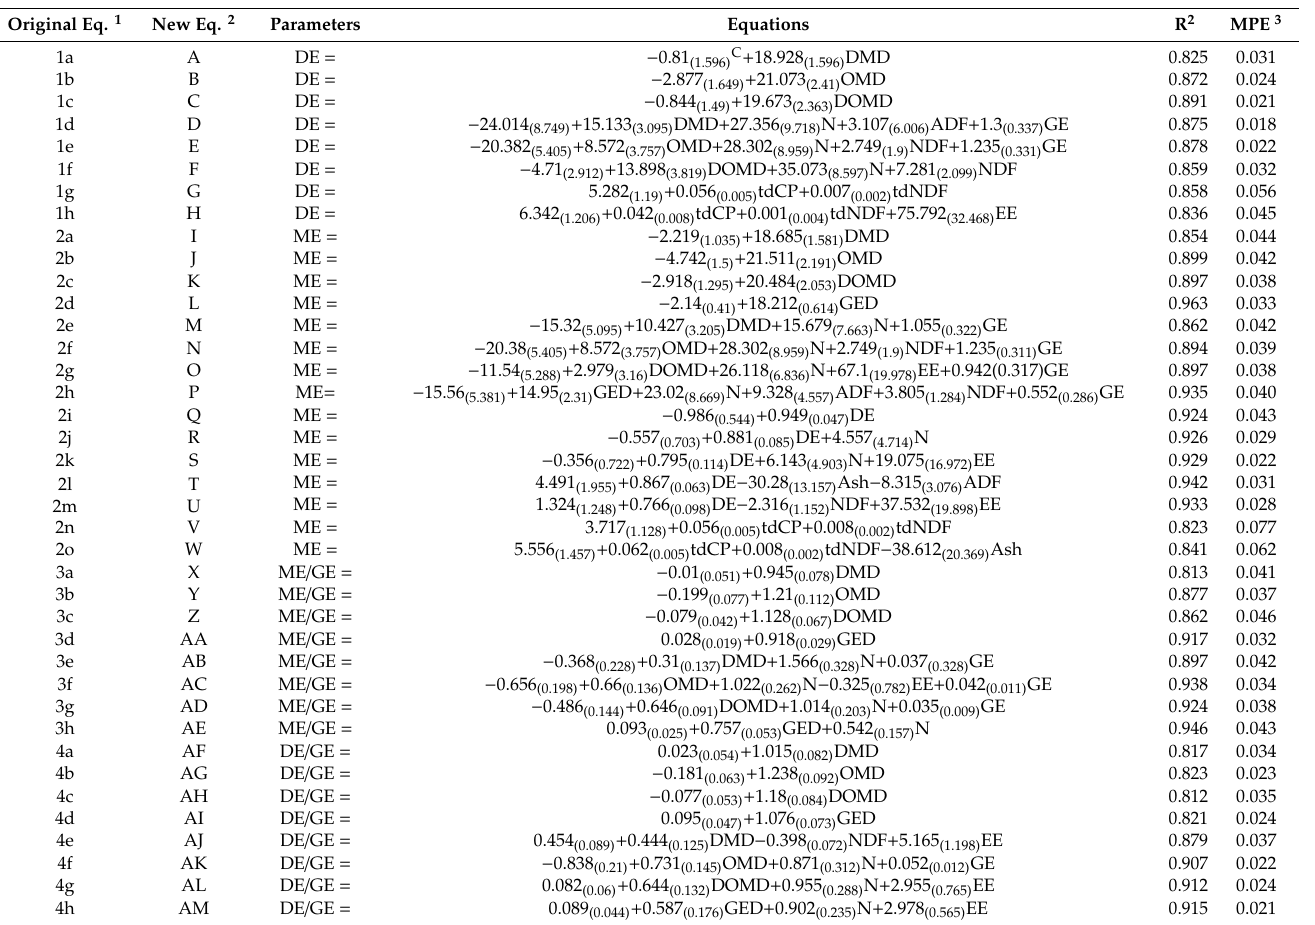
Table 6. Internal validation: prediction equations for DE and ME concentrations and ratios developed using two-thirds of the whole dataset ( n = 44). Original Eq.